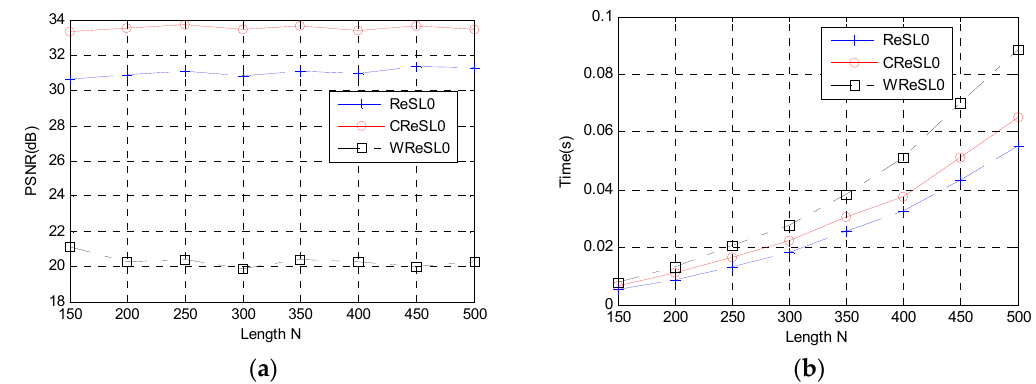
Figure 3. ( a ) PSNR of each algorithm for different signal lengths; ( b ) running time of each algorithm